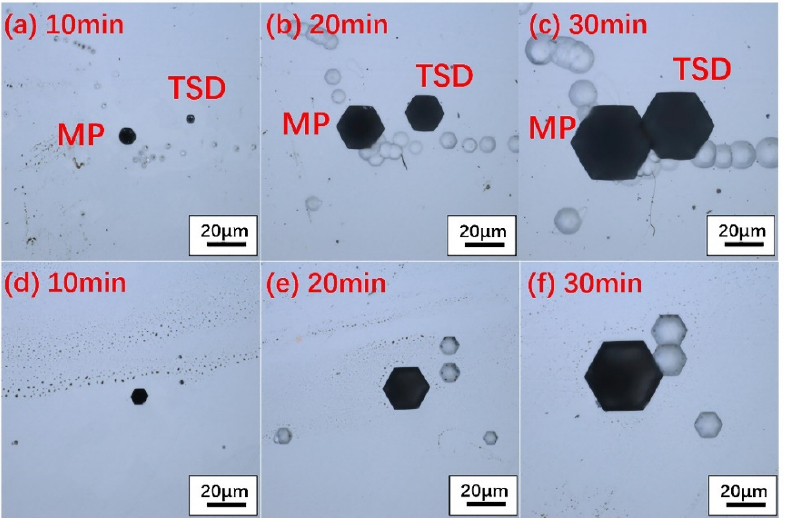
Figure 1 . Evolution of the morphology of micropipe etch pits with time in 4H-SiC (( a ) 10min,( b ) 20min,( c ) 30min) and 6H-SiC (( d ) 10min,( e ) 20min,( f ) 30min) under a laser confocal microscope.